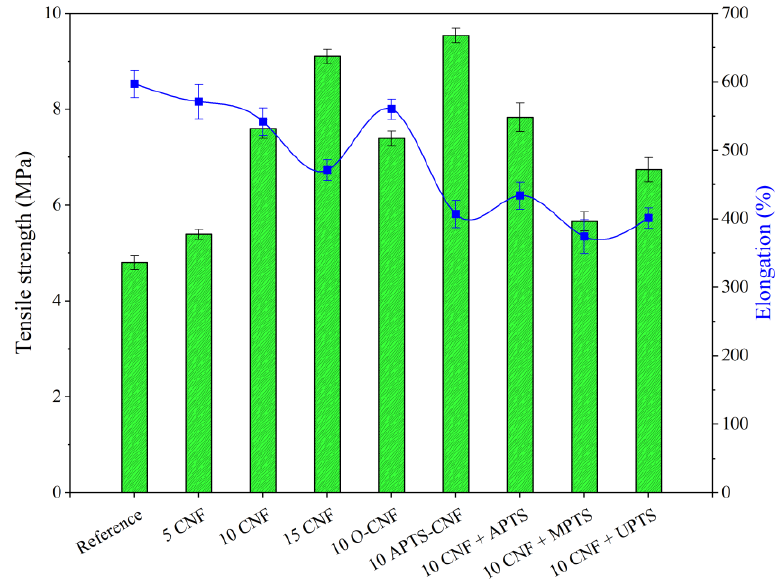
Figure 10. Tensile strength test results obtained for NBR composites with modified carbon nanofibers.